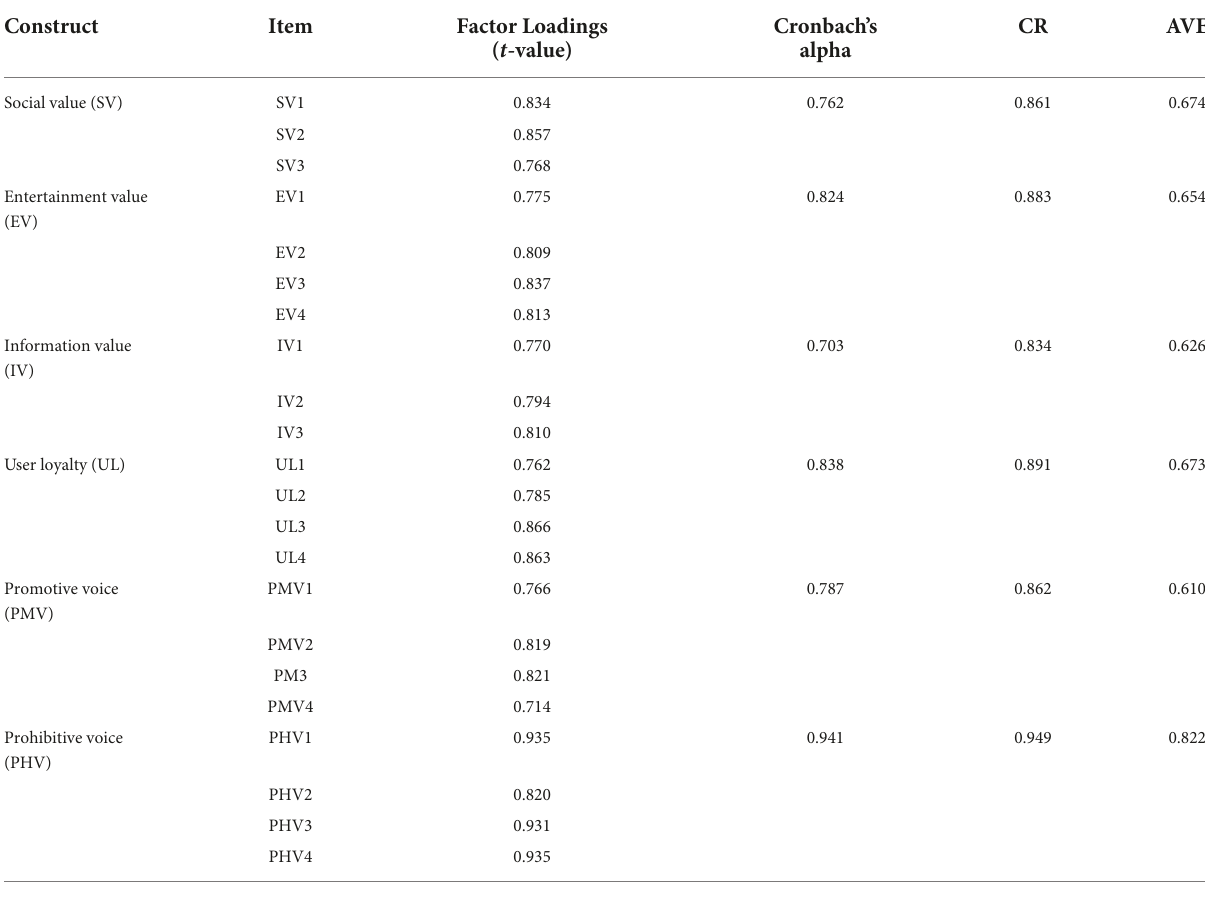
TABLE 2 Outer model analysis.